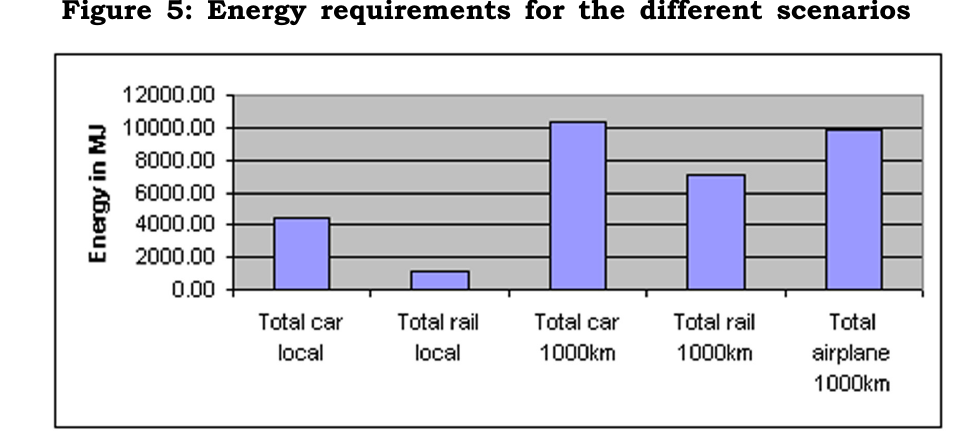
Figure 5: Energy requirements for the different